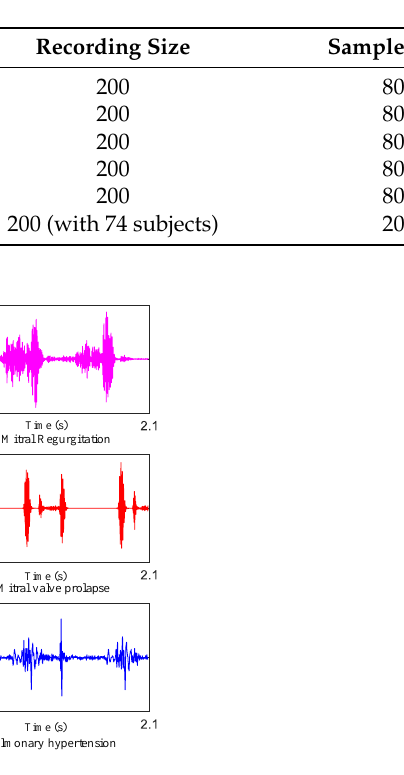
Figure 1. Typical examples of the PCG signals. ( a ) One example of AS; ( b ) One example of MR; ( c ) One example of MS; ( d ) One example of MVP; ( e ) One example of N; ( f ) One example of PH.